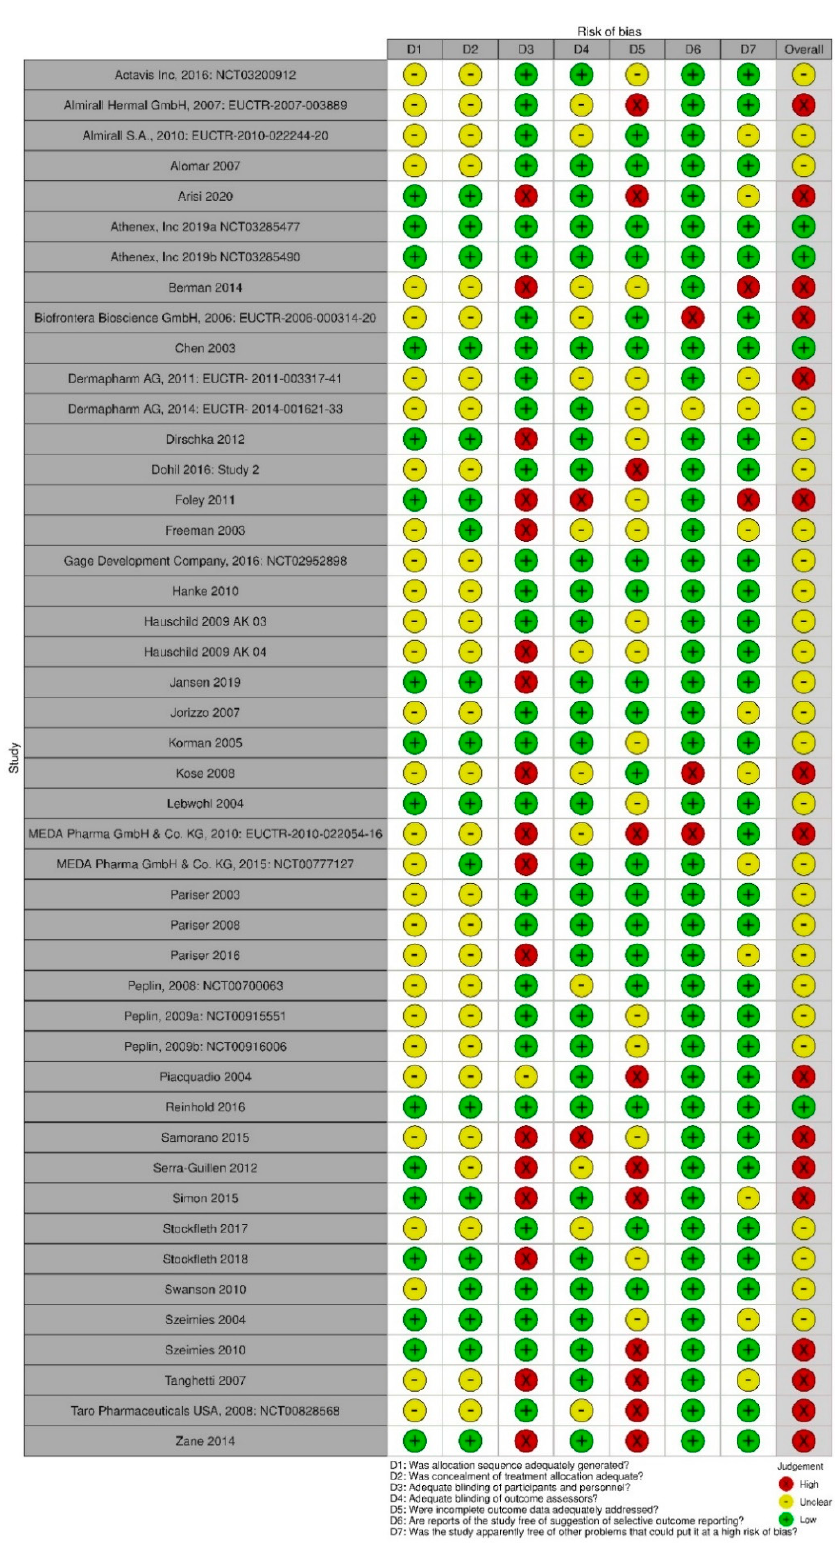
Figure 2. Summary Risk of Bias Assessment for the 46 studies included in the systematic review [95].